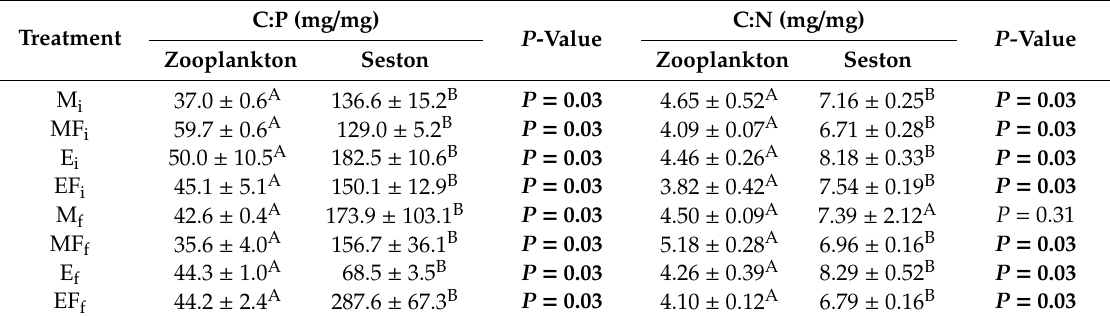
Table 6. Results of Mann–Whitney comparing mean values ( ± SE) of ratios C:P and C:N of zooplankton and seston in experimental mesocosms: E—eutrophic, M—mesotrophic, F—fish, i—initial (June) date, f—final (July) date; means labelled with the same letter are not significantly di ff erent at P < 0.05. Significant results ( P < 0.05) are shown in bold.